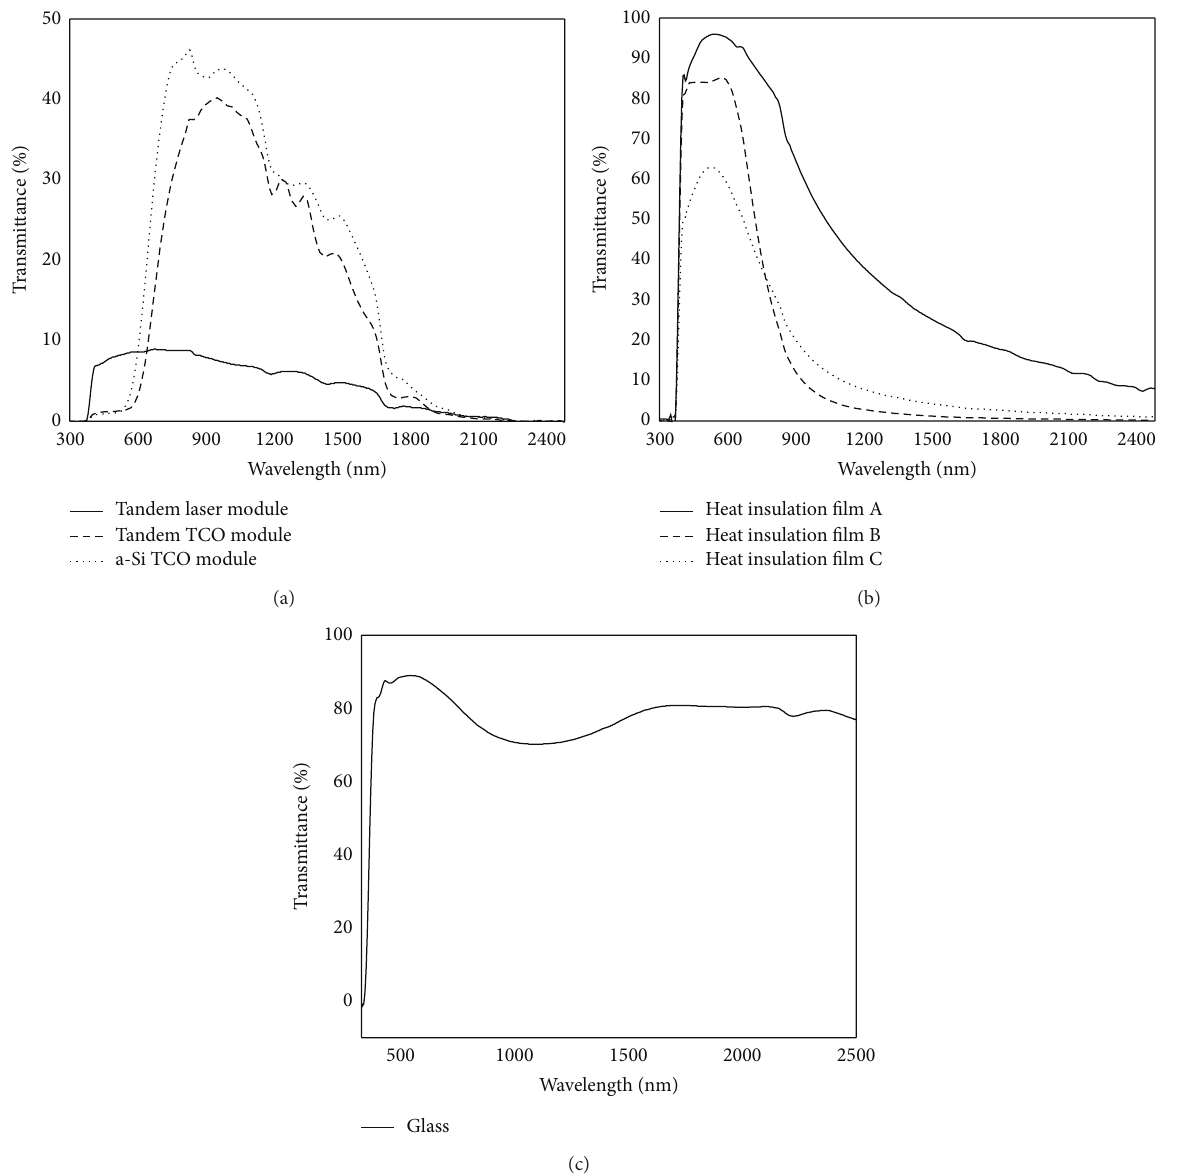
Figure 4: Transmittance spectra of each component: (a) semitransparent PV module, (b) heat insulation film, and (c) rear glass.